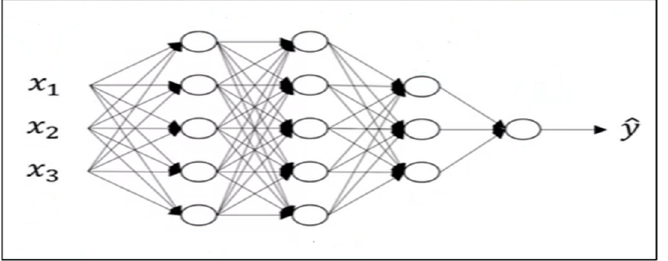
Figure 4. A Multi-Layer Perceptron network with 3 hidden layers. { x 1 , x 2 , x 3 } are the inputs and ˆ y is the single output